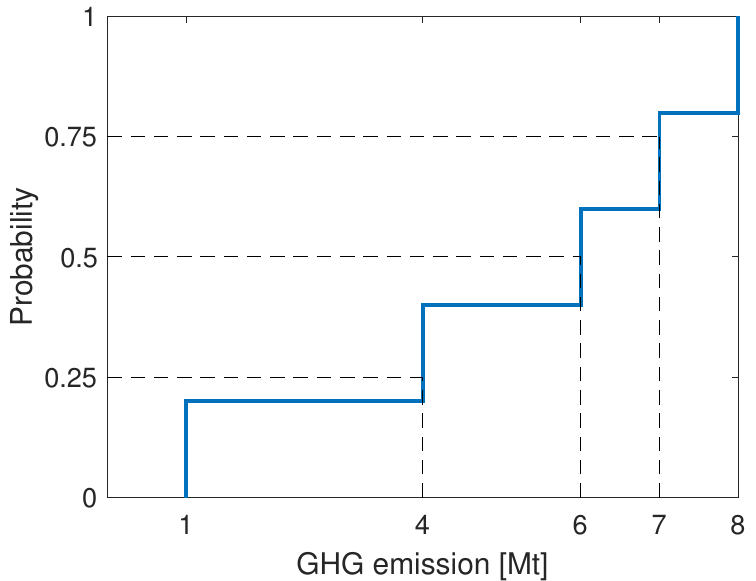
Figure 2. The determination of the percentiles based on an example empirical distribution function. The maximum value is 8 Mt , the third quartile is 7 Mt , the median is 6 Mt , the first quartile is 4 Mt , and finally, the minimum is 1 Mt